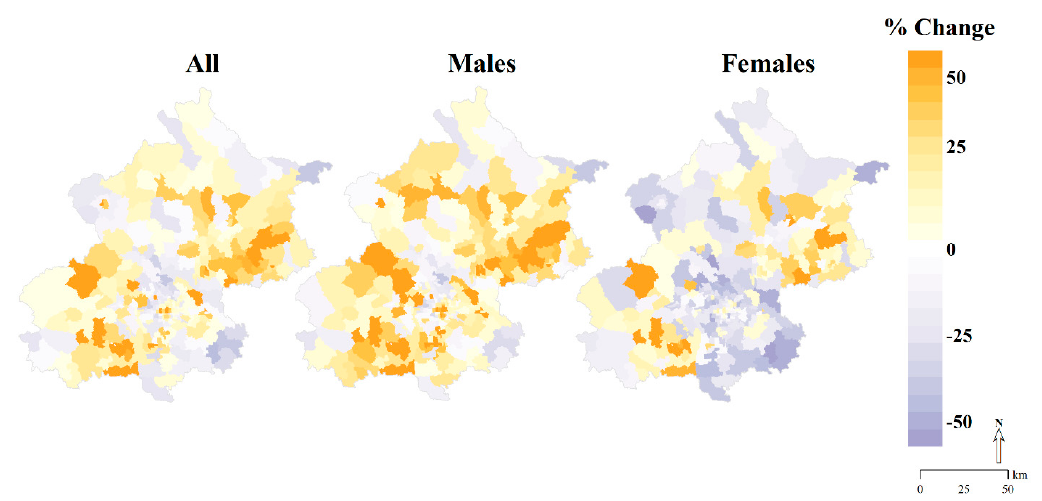
Figure 3. Percentage Changes in the Age − Standardized Incidence of Acute Myocardial Infarction in Beijing Residents Aged ≥ 35 Years at the Township Level, 2007–2018.